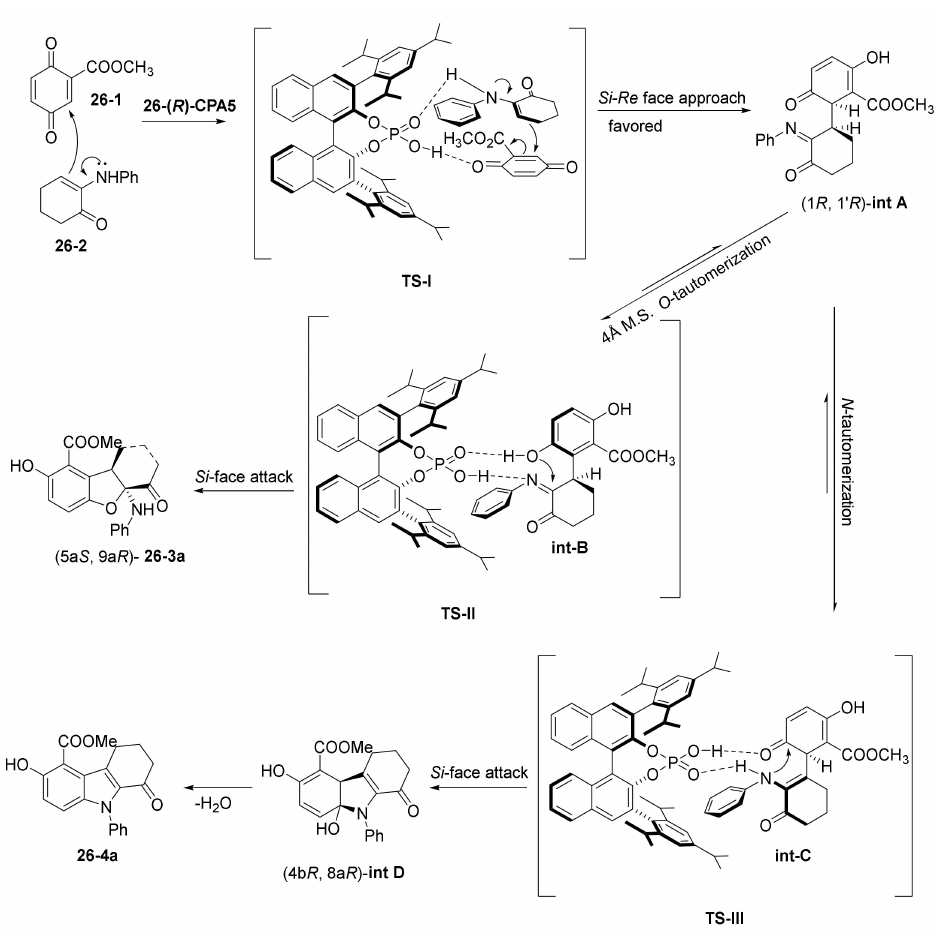
Scheme 51. Proposed reaction mechanism for formal oxo- and aza-[3+2]